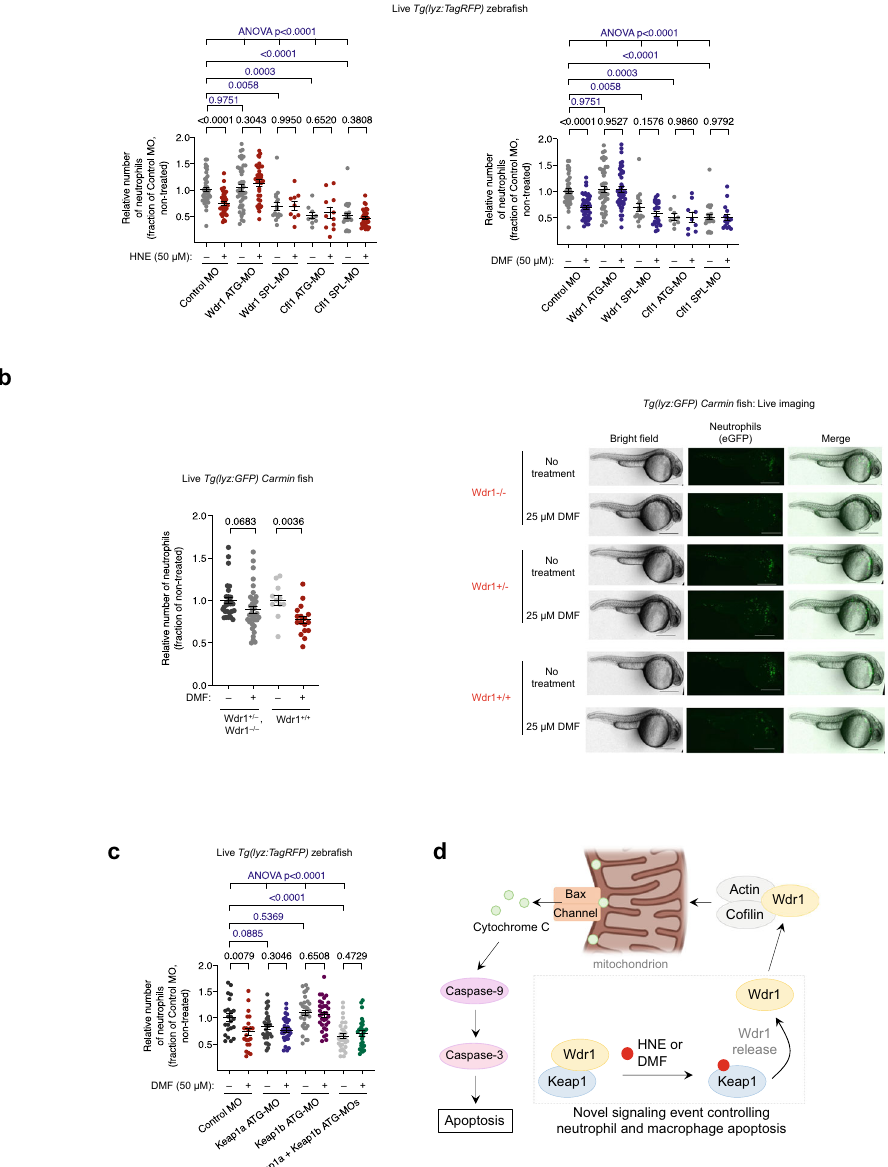
Fig. 5 Bulk exposure of embryos to HNE or DMF triggers Wdr1- and co fi lin-dependent apoptosis of neutrophils. a Similar experiment as in Fig. 4b except Tg(lyz:TagRFP) embryos were injected with Halo-TEV-Keap1 and the indicated MO (500 μ M). See also Supplementary Fig. 16. In all cases, embryos were exposed to HNE or DMF at 30hpf, and neutrophils were counted at 36hpf. Inset at right: Fold changes (treated/non-treated) in neutrophil counts in each knockdown background. P values in black were calculated with two-tailed unpaired Student ’ s t -test. P values in blue were calculated with ANOVA and Dunnett ’ s multiple comparisons test (see also Supplementary Fig. 1b). Note that the non-treated data sets in each plot are the same, but presented in each plot for clarity. b Tg(lyz:eGFP) carmin embryos were treated at 30hpf with DMF for 4h, and neutrophils were counted subsequently. See also Supplementary Fig. 18a – d. Scale bars, 500 μ m. Inset: analysis of fold change (DMF/non-treated) (see Fig. 2d) in neutrophil count. P values were calculated with two-tailed unpaired Student ’ s t -test (Supplementary Fig. 1b). c g(lyz:TagRFP ) embryos were injected with MOs targeting Keap1a, Keap1b, both, or control MO (500 μ M). See also Supplementary Fig. 19. At 30hpf, embryos were treated with DMF for 6h, then neutrophils were counted. P values in black were calculated with two-tailed unpaired Student ’ s t - test. P values in blue were calculated with ANOVA and Dunnett ’ s multiple comparisons test (see also Supplementary Fig. 1b). d Model of the Keap1-modi fi cation- speci fi c apoptotic axis necessary for DMF mode-of-action in immune-cell depletion. Upon Keap1-electrophile-modi fi cation, Wdr1 is released from Keap1 binding. In concert with co fi lin, Wdr1 promotes Bax-dependent mitochondrial-targeted activation of Caspase-3. All data present mean±SEM. All sample sizes are listed in Supplementary Methods. Source data are provided as a Source data fi